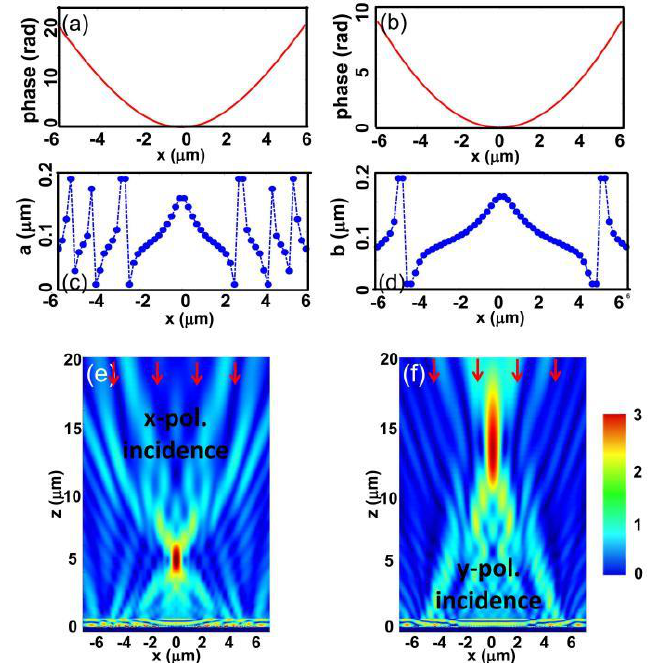
Figure 3. Phase profile to focus incident light for ( a ) x- and ( b ) y-polarization incidences. Corresponding lengths of ( c ) x-direction length a and ( d ) y-direction length b of the rectangle antenna in metalens design. The electric field intensities for ( e ) x- and ( f ) y-polarization incidence, respectively.